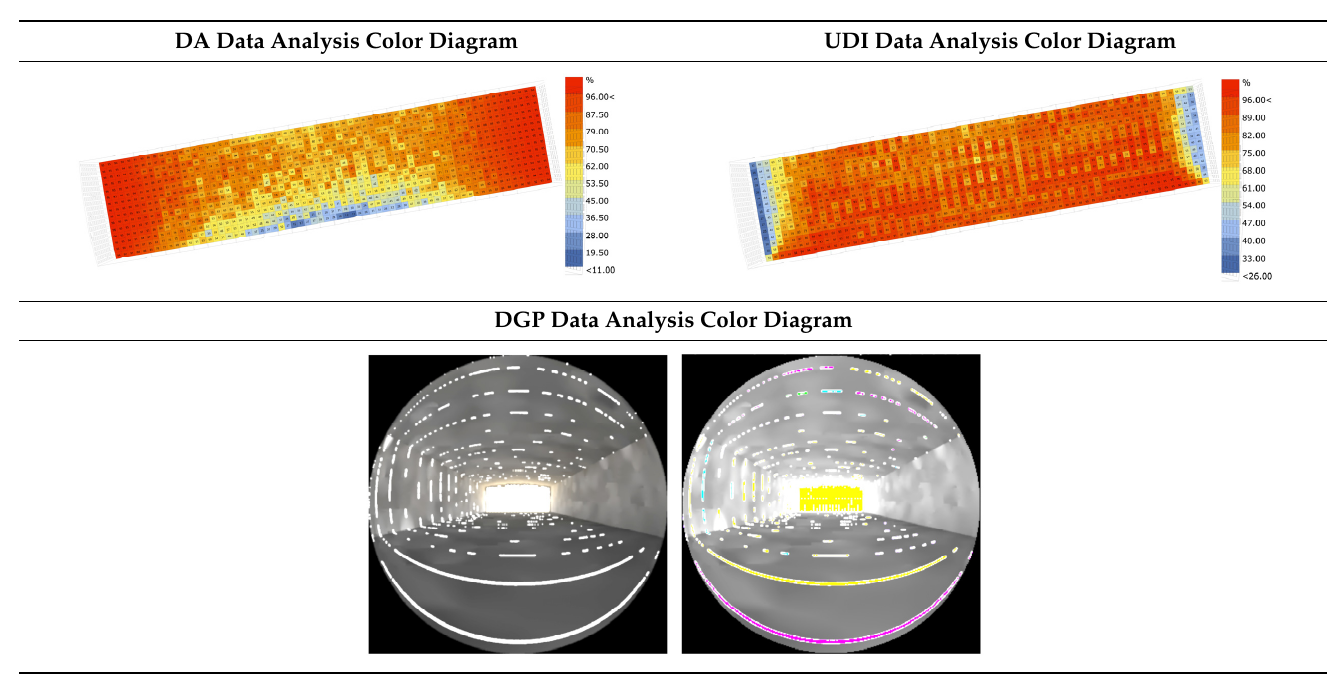
Table 5. Visual analysis of natural lighting